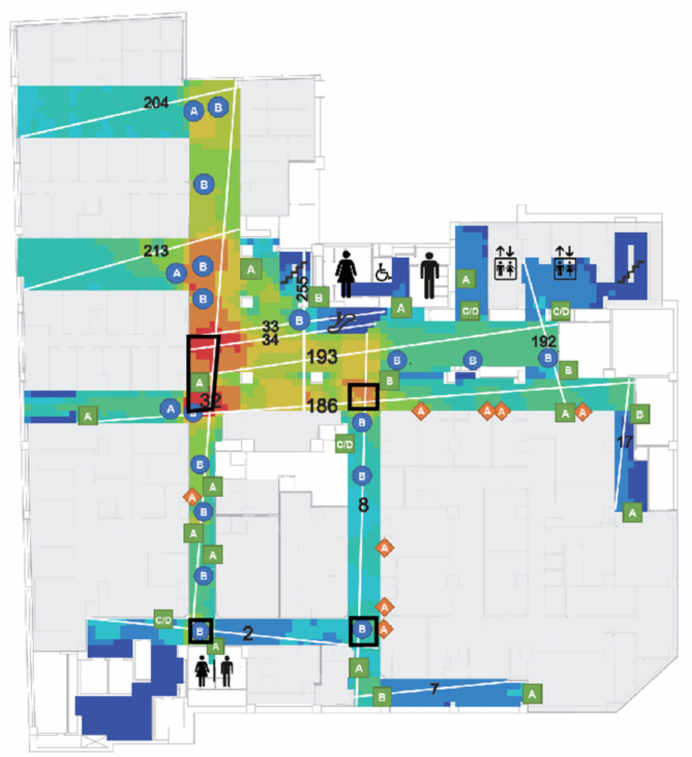
Figure 11. The overlapping map of the signage, axis and route isovist on the first basement floor of the CCH/CKB